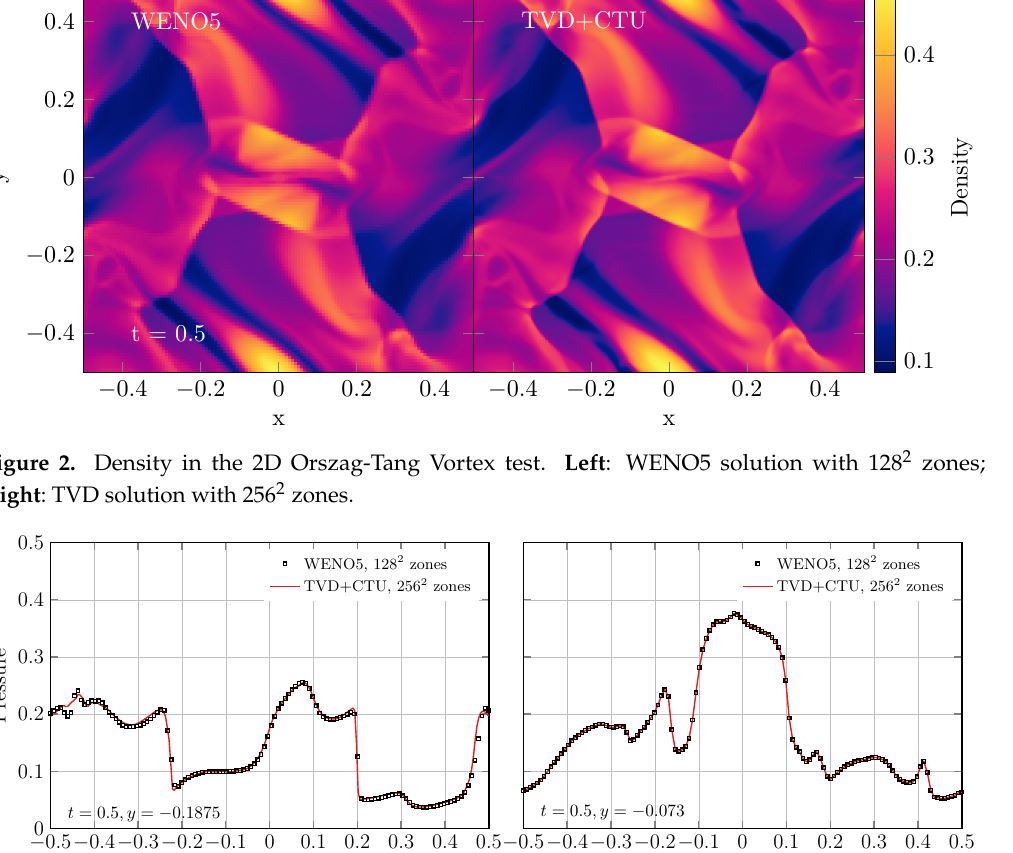
0.1875 ( left ) and y = 0.073 ( right ). − −